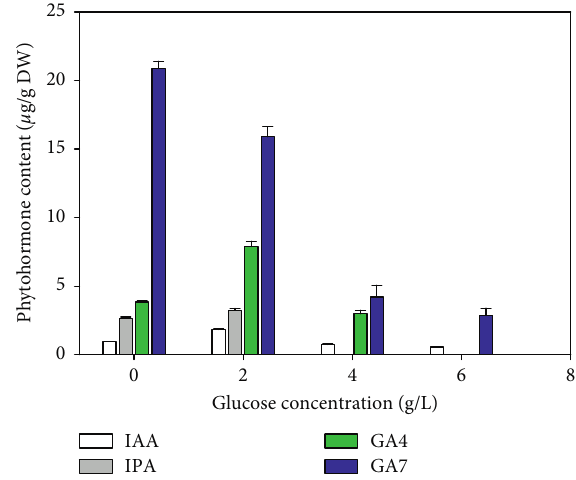
Figure 2: Profile and concentration of endogenous phytohor- mones produced by C. sorokiniana TH01 grown mixtrophically in BG-11 medium under different glucose concentration ( n � 6, p < 0 . 05). IAA, indole-3-acetic acid; IPA, 3-indolepropionic acid; GA4, gibberellin A4; GA7, gibberellin